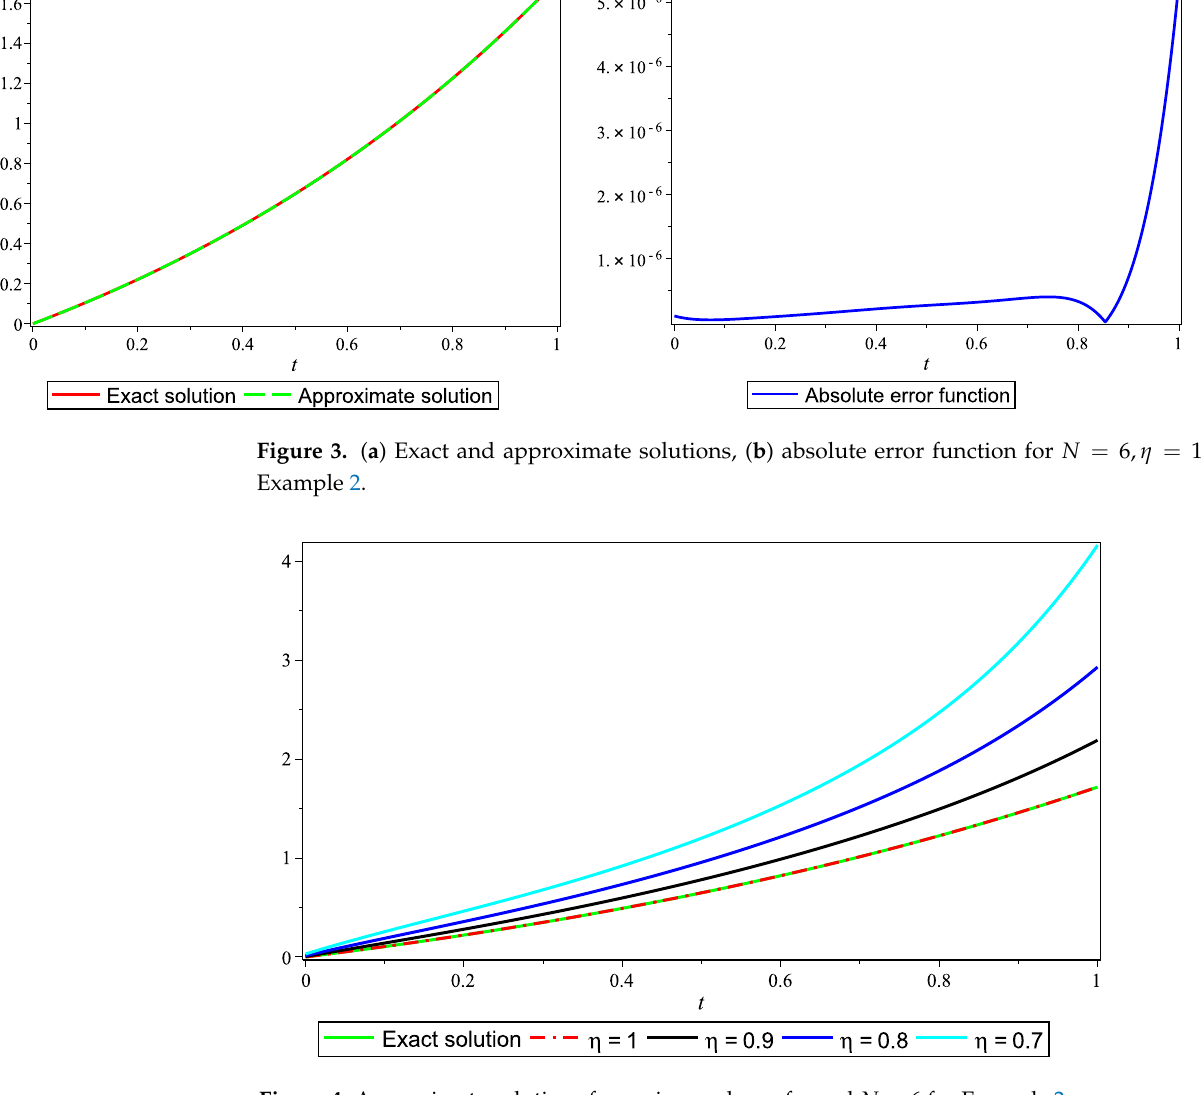
Figure 4. Approximate solutions for various values of η and N = 6 for Example